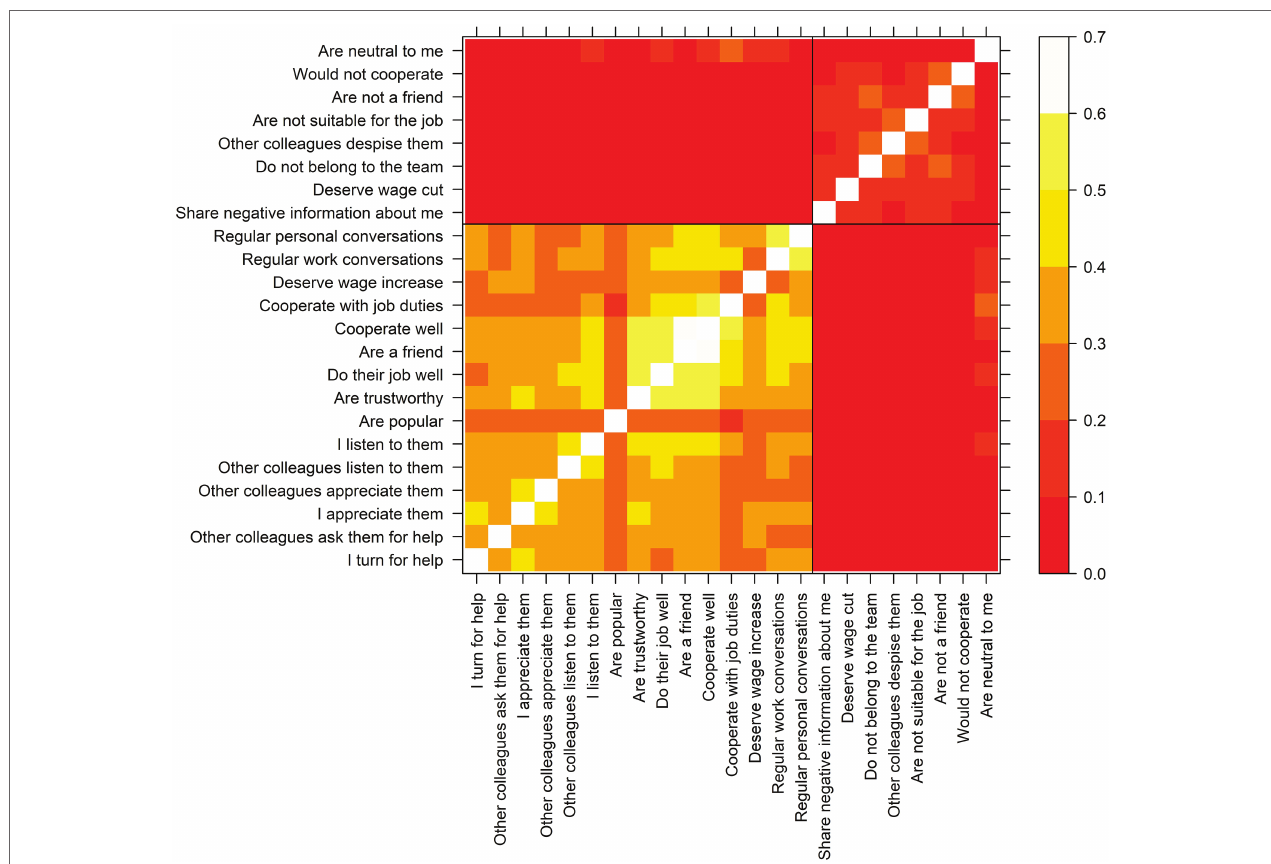
FIGURE 2 | Overlap between network items (mean Jaccard indices for all six